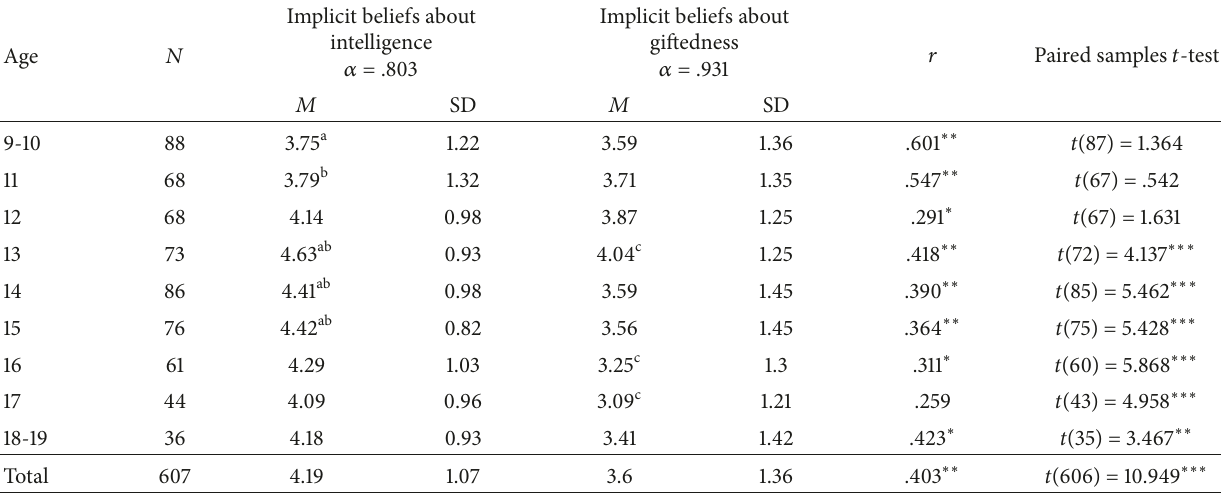
Table 5: Implicit beliefs about intelligence and giftedness among different age groups.